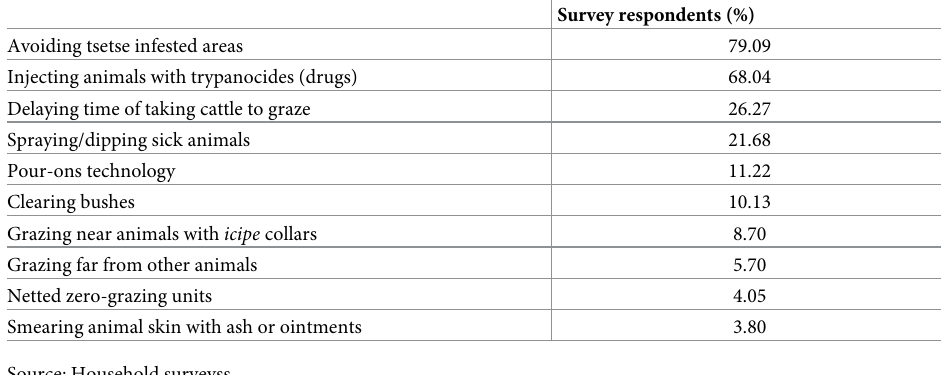
Table 6. Tsetse fly and trypanosomiasis management strategies in Kwale